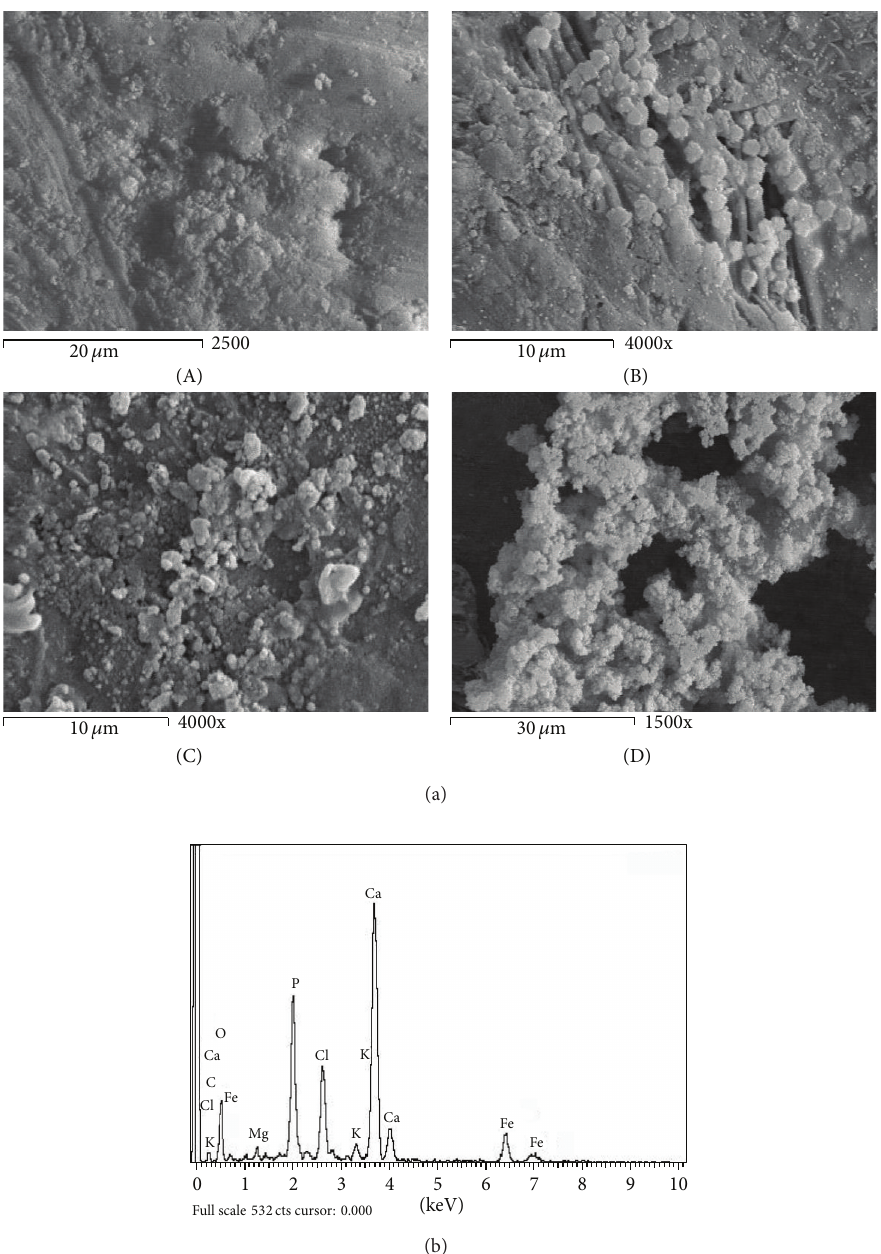
Figure 3: (a) SEM micrograph of Mn-doped glass ceramics (A) before, (B) after 1 week, (C) after 2 weeks, and (D) after 4 weeks of immersion in SBF. (b) EDAX of Mn-doped glass ceramics after 4-week immersion in